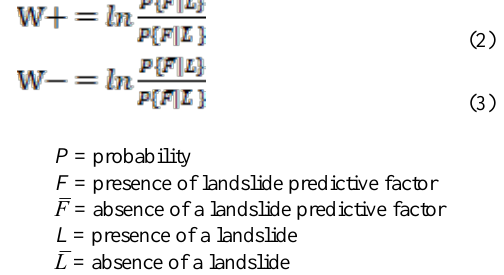
By overlaying the landslide layer with each of the landslide predictor layers, a spatial association between the landslides and